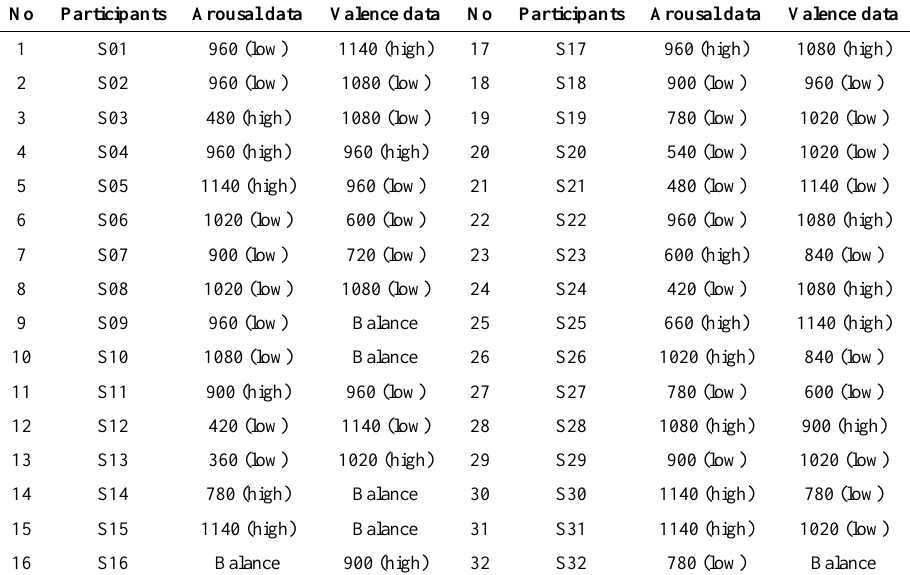
Table 2. Distribution of minor class in DEAP dataset before